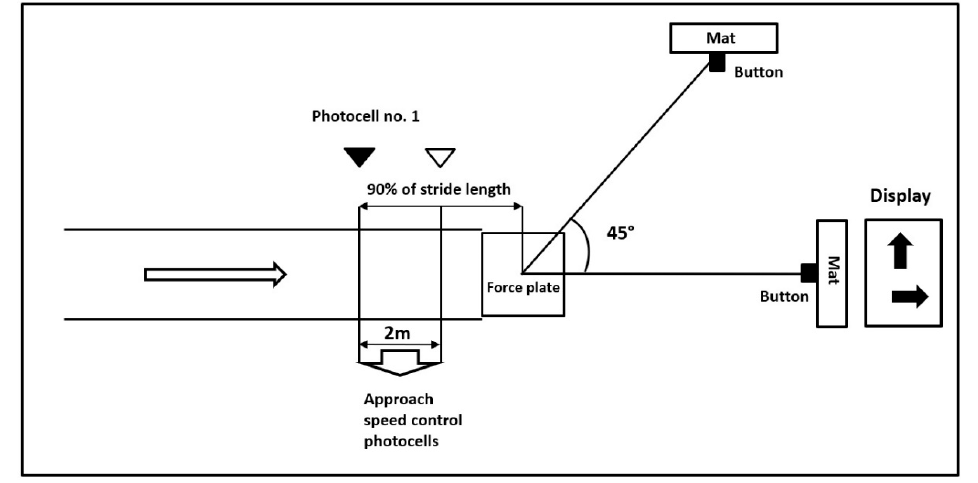
Figure 3. Unanticipated cutting maneuver scheme.